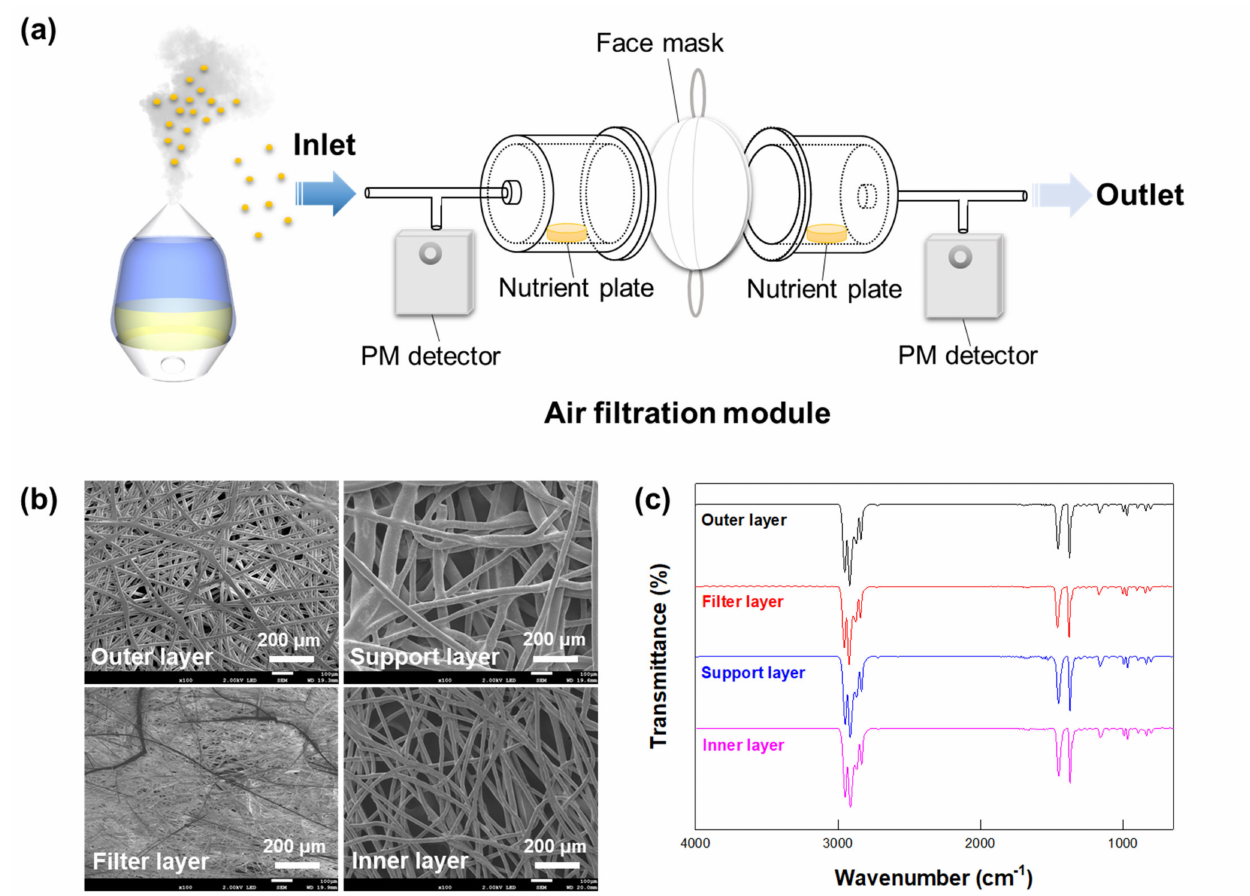
Figure 1. ( a ) Schematic illustration of the filtration system used to evaluate the effectiveness levels of masks against PMs and airborne bacteria-containing droplets. ( b ) Scanning electron microscopy (SEM) images and ( c ) Fourier-transform infrared spectroscopy (FT-IR) spectra of the various layers of a KF80 mask (category